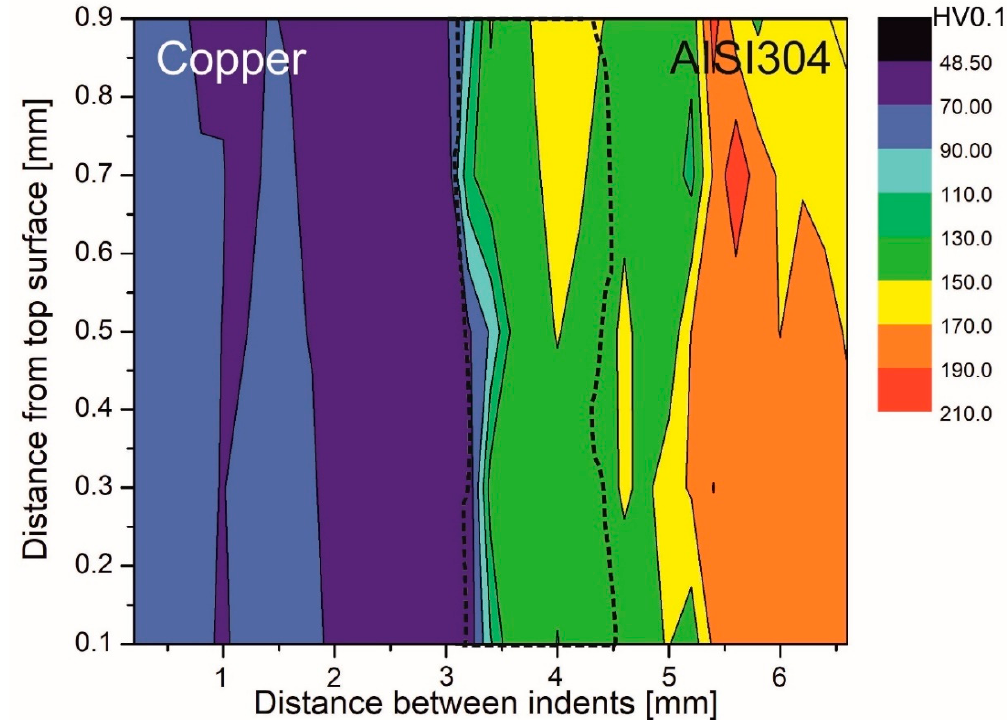
Figure 11. Microhardness map for dissimilar metals-welded joint No. 5.